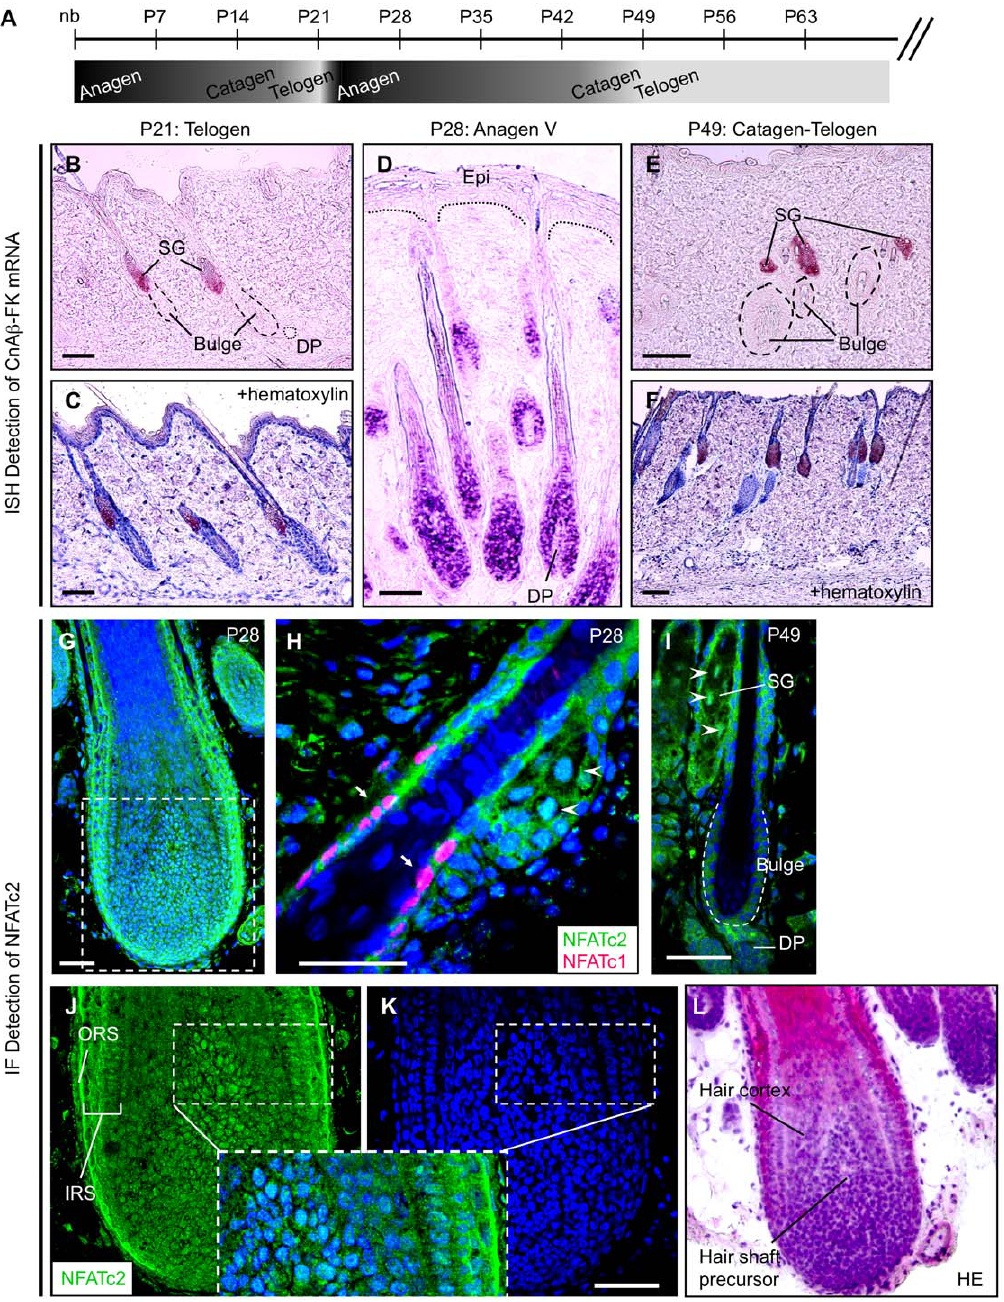
Figure 3. CnAß-FK mRNA and NFATc2 Localizations in rat skin. (A) Time-scale of the hair cycle in male Wister rats. Each phase was determined using criteria described previously [42]. The intensity of thegray shadingindicatestherate of proliferation of follicular keratinocytes: white , proliferation activity , black. (B–F) Distribution of CnAß-FK mRNA. B and C, telogen stage. D, late phase of anagen stage. E and F, transition stage from catagen to telogen. (C and F) Sections were counter-stained using hematoxylin (blue staining). (G–J) Results of immunohistochemical analysis of NFATc2 (green) and NFATc1 (red) in hair follicles. Cell nuclei were visualized by Hoechst staining (blue in G–I and K). (G) NFATc2 expression in hair follicle at postnatal day 28. (H) NFATc2 and NFATc1 expression in bulge and SG cells at postnatal day 28. Arrows, NFATc1 expression in bulge cells. Arrowheads, nuclear localization of NFATc2 in SG cells. (I) NFATc2 expression at postnatal day 49. Arrowheads indicate localization of NFATc2 in nuclei of SG cells. (J and K) Higher magnification image of the boxed region in G. (J) NFATc2 expression. (K) Hoechst staining. (L) Hematoxylin-eosin (H.E.) staining of hair follicles at postnatal day 28. After immunofluorescence staining, H.E. staining was performed in the same section to reveal the histology of hair follicle. DP, dermal papillae; IRS, inner root sheath; ORS, outer root sheath; SG, sebaceous gland. Scale bars in B–F, 100 m m; in B, C, and G–K, 50 m m. doi:10.1371/journal.pone.0017685.g003 protein was not observed in proliferating keratinocytes in the weak in the hair germ region and was undetectable in bulge stem proximal part of the hair shaft (arrows) at the first anagen stage cells and in DP cells. In contrast, cyclin G2 was detected in SG (Fig. 5E). In HF at the telogen stage, cyclin G2 expression was cells where CnAß-FK mRNA was detected at the telogen stage